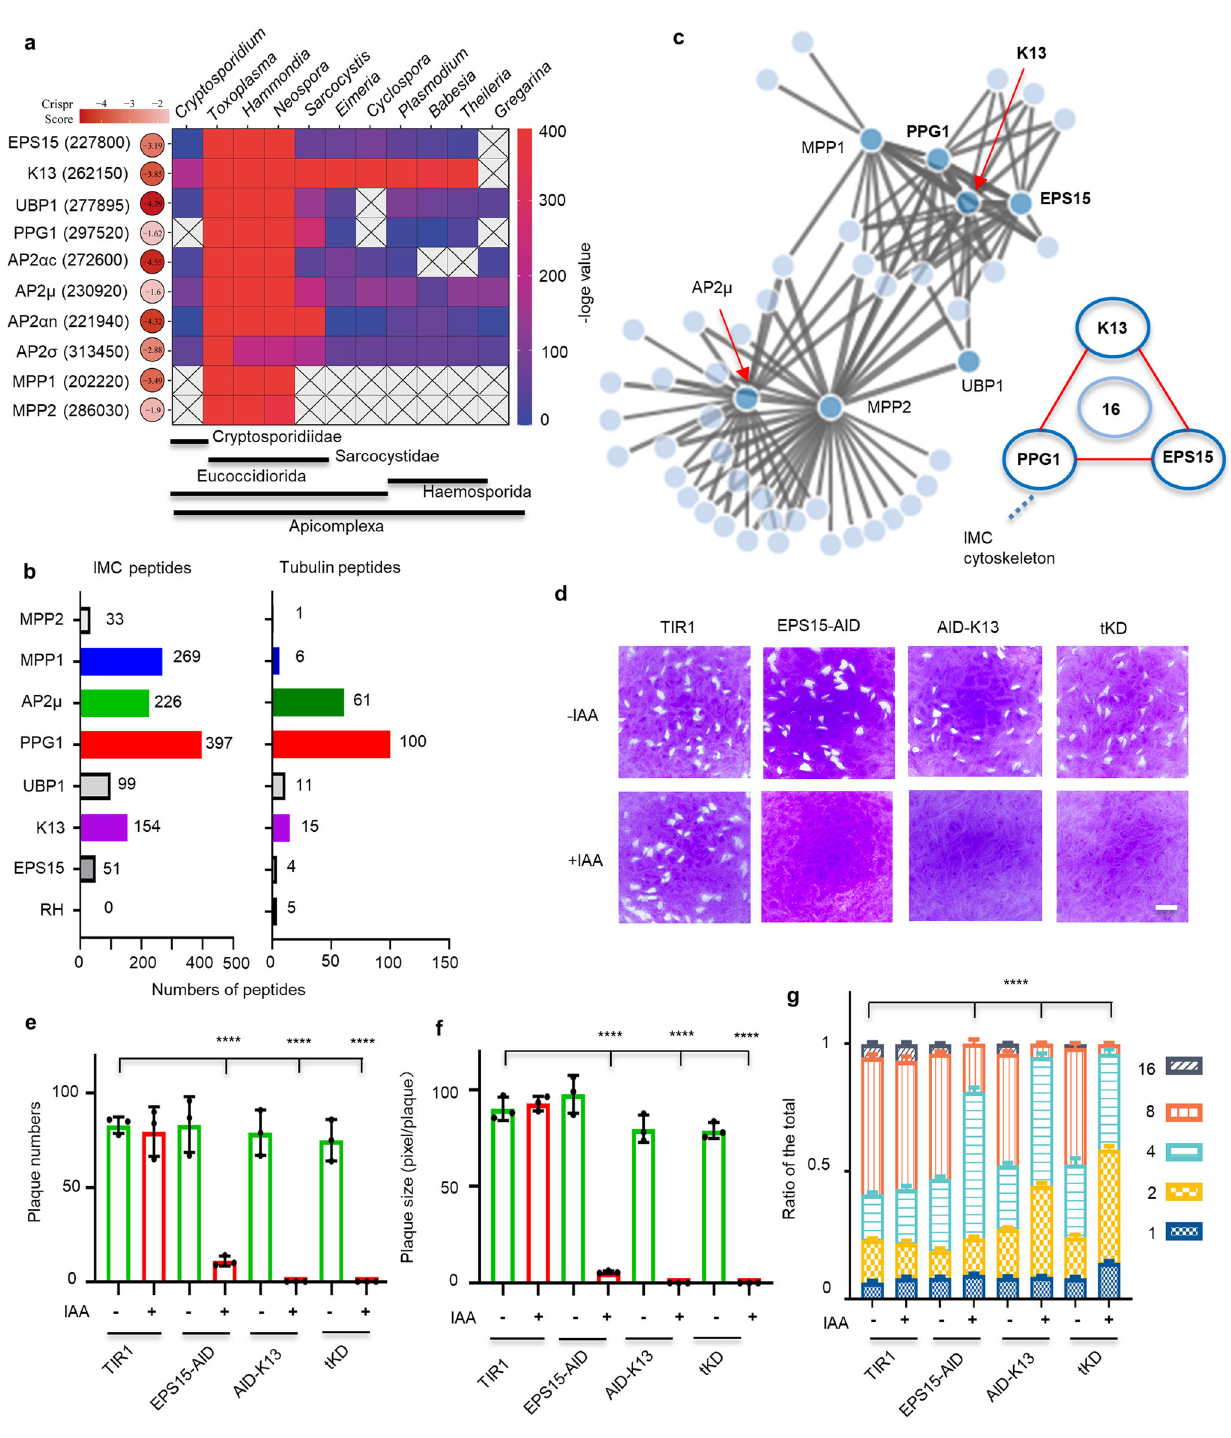
Fig. 2 | Kelch13 mediates the protein interaction network at the micropore. a Conservation of micropore proteins in representative species of the apicom- plexans. The protein names with the corresponding ID (in brackets) were listed, followed by CRISPR fi tness scores and the heatmap 55 by the side of a conservation heatmap. The heatmaps were correspondingly scaled by – log E values and CRISPR scores. b Peptide numbers of IMC proteins and microtubules identi fi ed by proxi- mity biotin labeling. c The proximity-based interactome of micropore proteins, showing interactions of the bait (deep blue) and the prey (light blue) fi ltered through a R-based SFINX package for 7 TurboID fusions ( N =2 datasets for each) with strictness=4 ( p value<0.00005). A hypergeometric test was used in the SFINX analysis. The core nodes K13, PPG1 and EPS15 shared the same set of inter- actors. d – f PlaqueformationofAID linesgrownin±IAAfor7days.EPS15,PPG1and